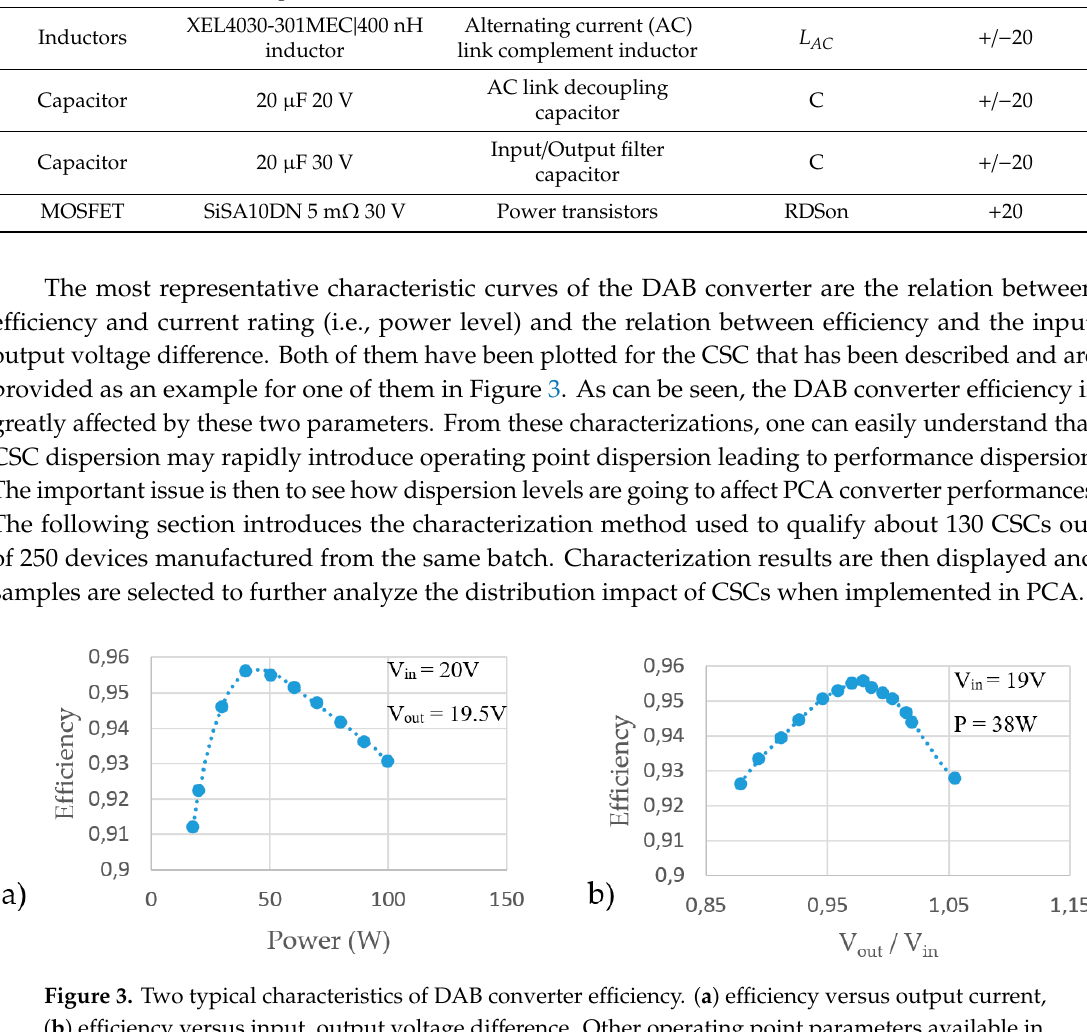
Table 2. DAB converter component list. Includes the main value for the components and their dispersion range, when available.